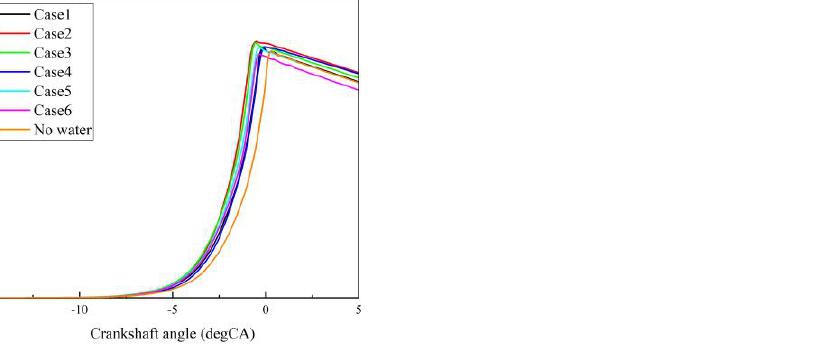
Figure 14. OH radical mass in the cylinder in different water injection cases (CR = 10.3, ignition time = − 14 degCA).